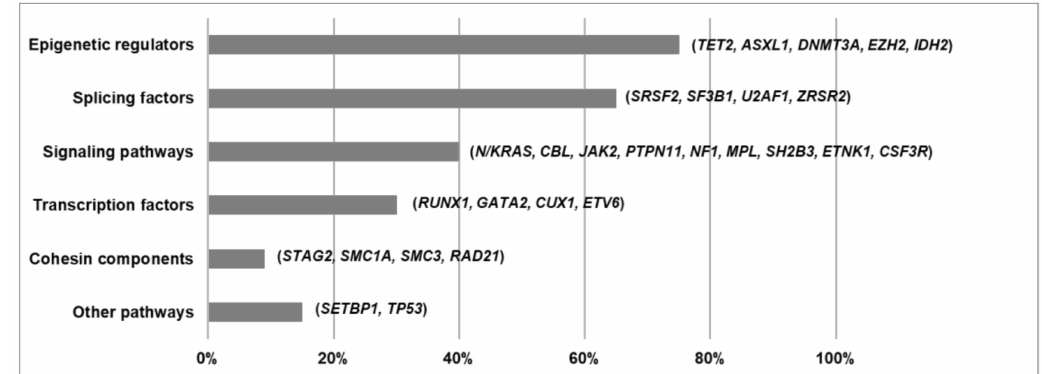
Figure 2. Functional pathways affected in MDS/MPN. Frequency of mutations affecting each pathway/functional category in MDS/MPN overlap syndromes. Based on data from Itzykson et al. [2], Patnaik et al. [3], Palomo et al. [4], Patnaik et al. [26] and Bose et al.